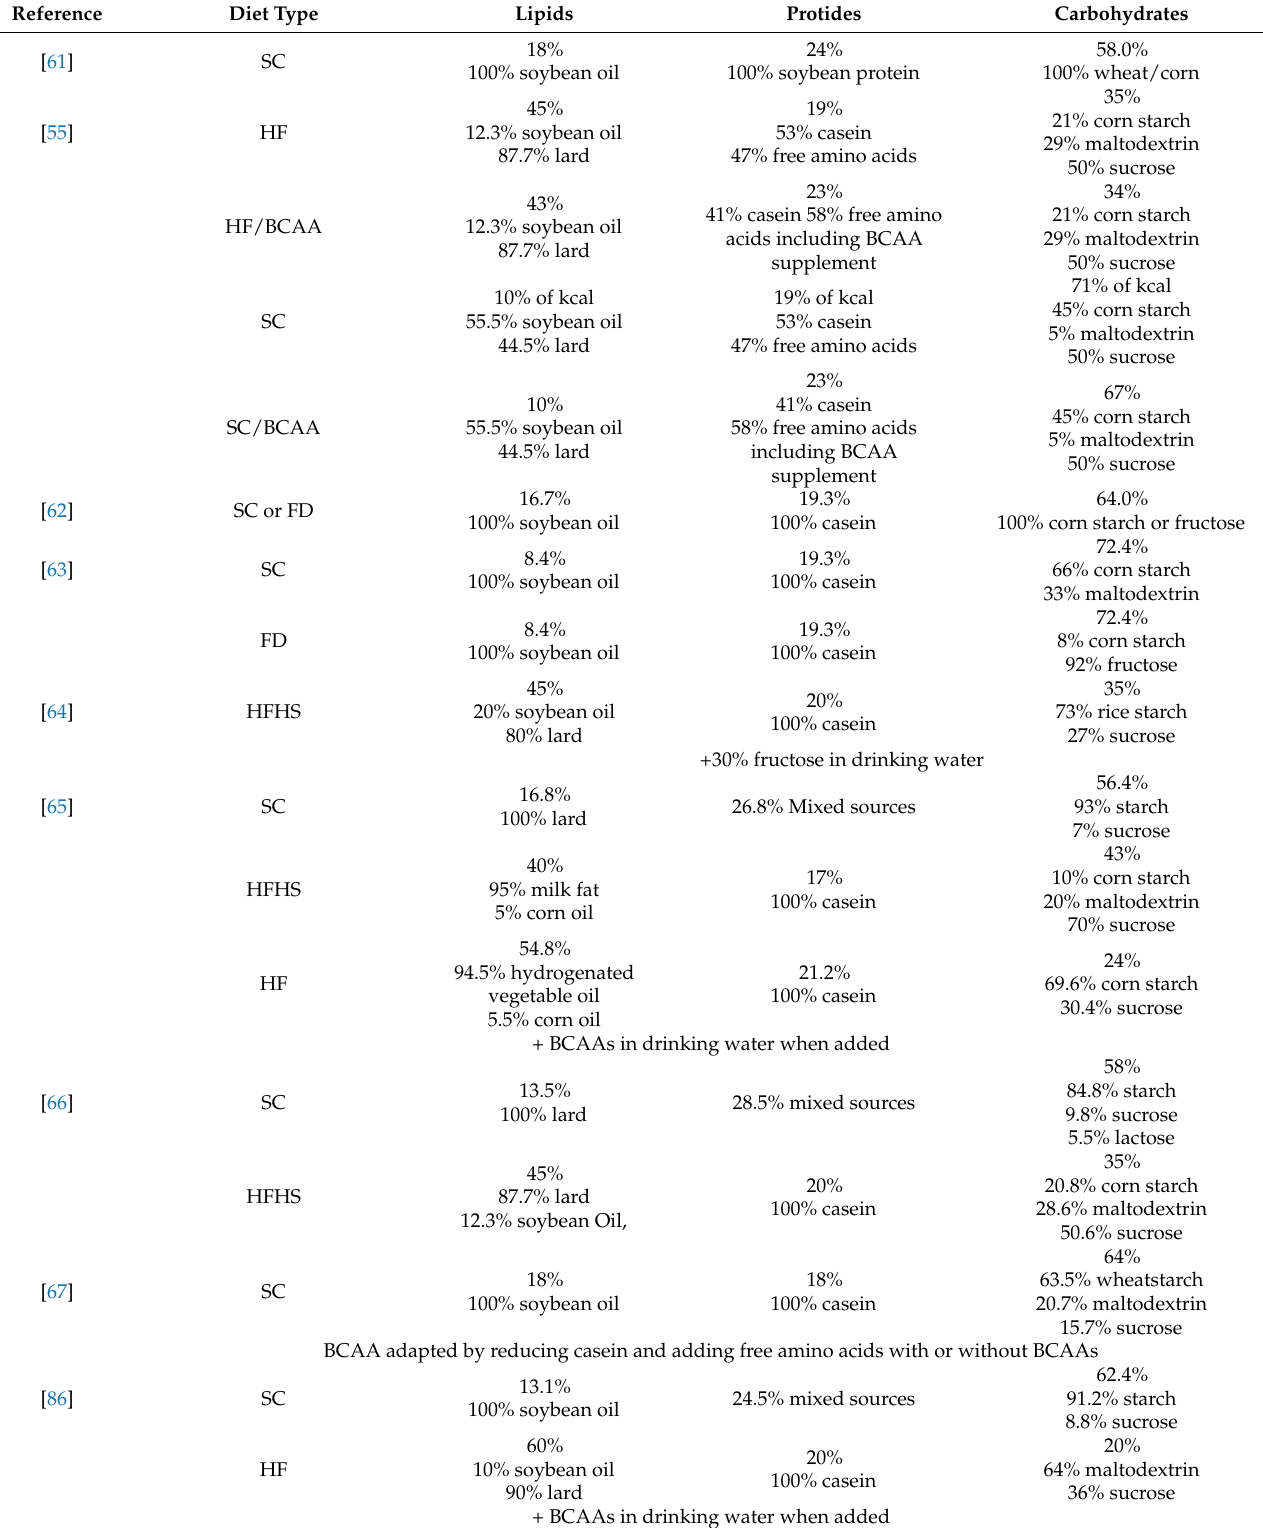
Table 2. Nutritional conditions in some of the cited experimental